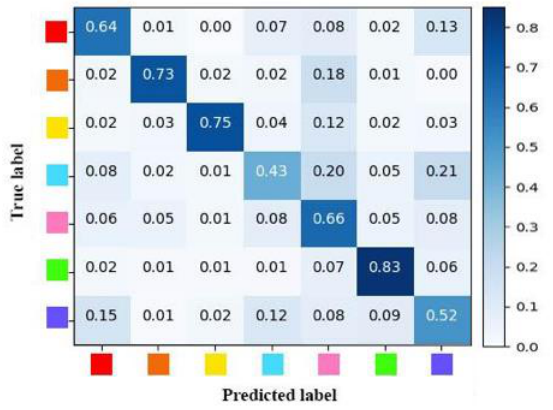
Table 2: Confusion matrix to analyse the results of the supervised classification of a portion of Pecile’s wall at scale 1:20.